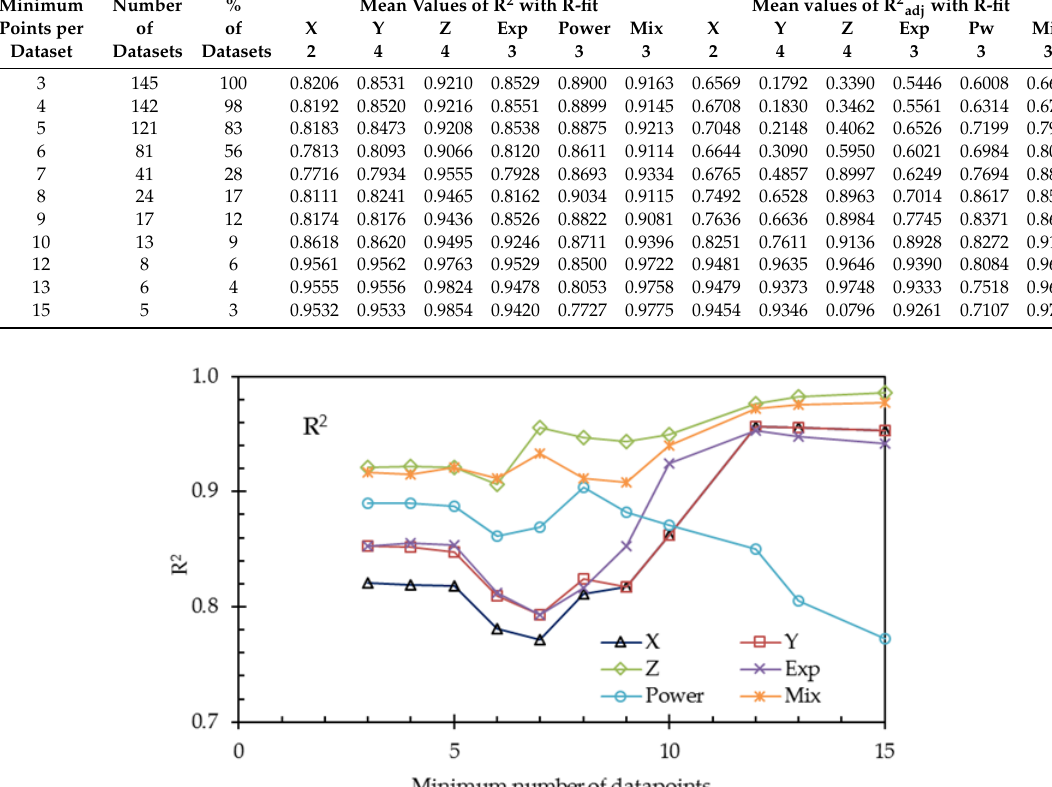
Table 10. Results of fitting with restricted numbers of datasets.